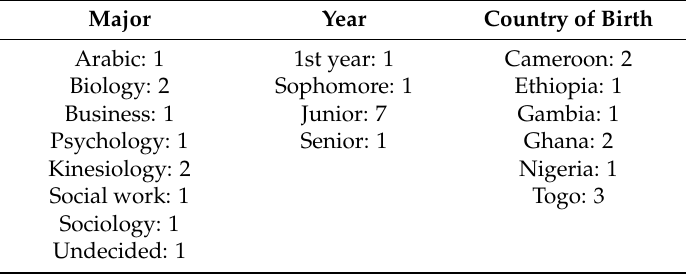
Table 2. Major, Year in College and Country of Birth ( n = 10).